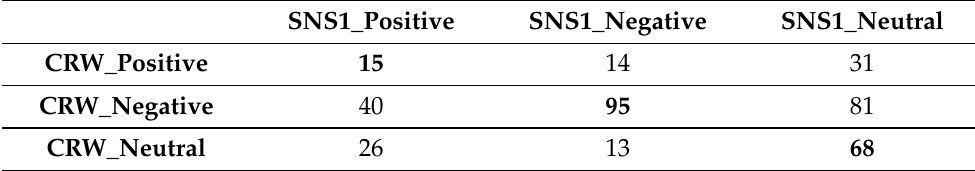
Table 6. Confusion matrix: SentiStrength (SNS)1 vs. CRW.